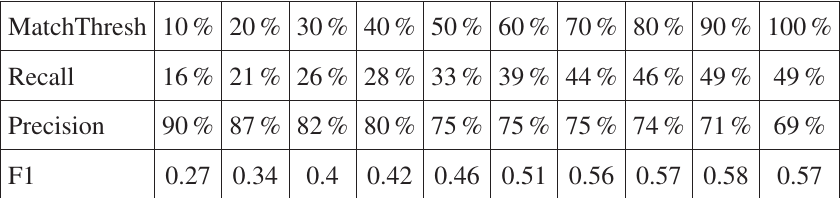
Table 5. Experimental Results for various values of MatchThresh.